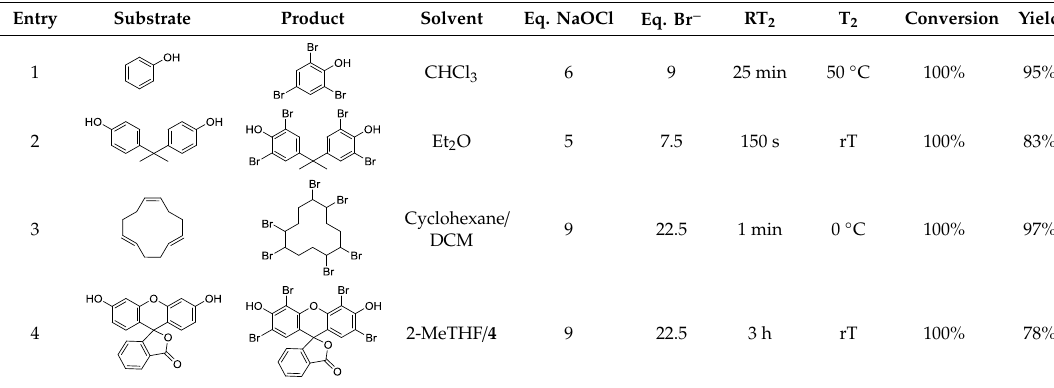
Table 1. Synthesis of four indicative organobromine compounds via in-situ Br 2 generation and bromination .